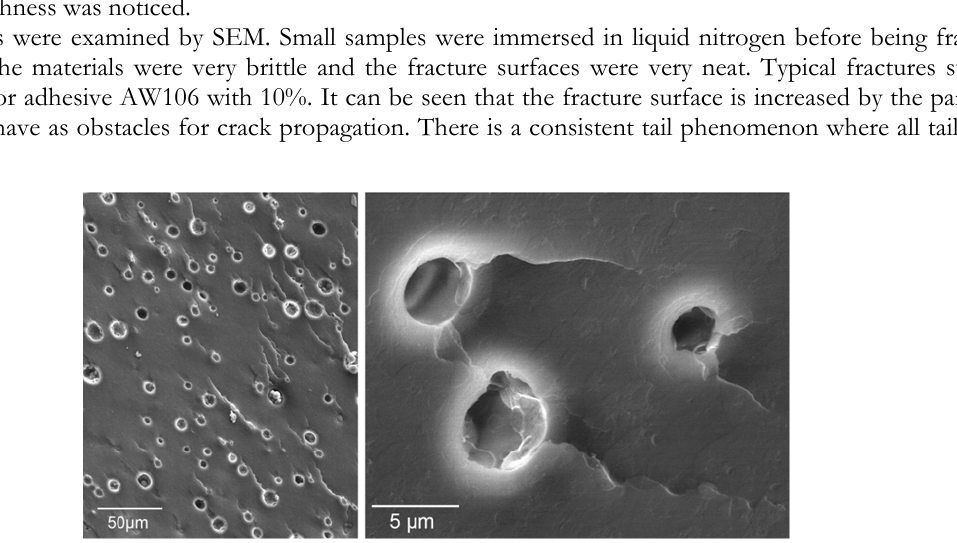
Figure 10: Fracture surface obtained by scanning electron microscopy for adhesive AW106 with